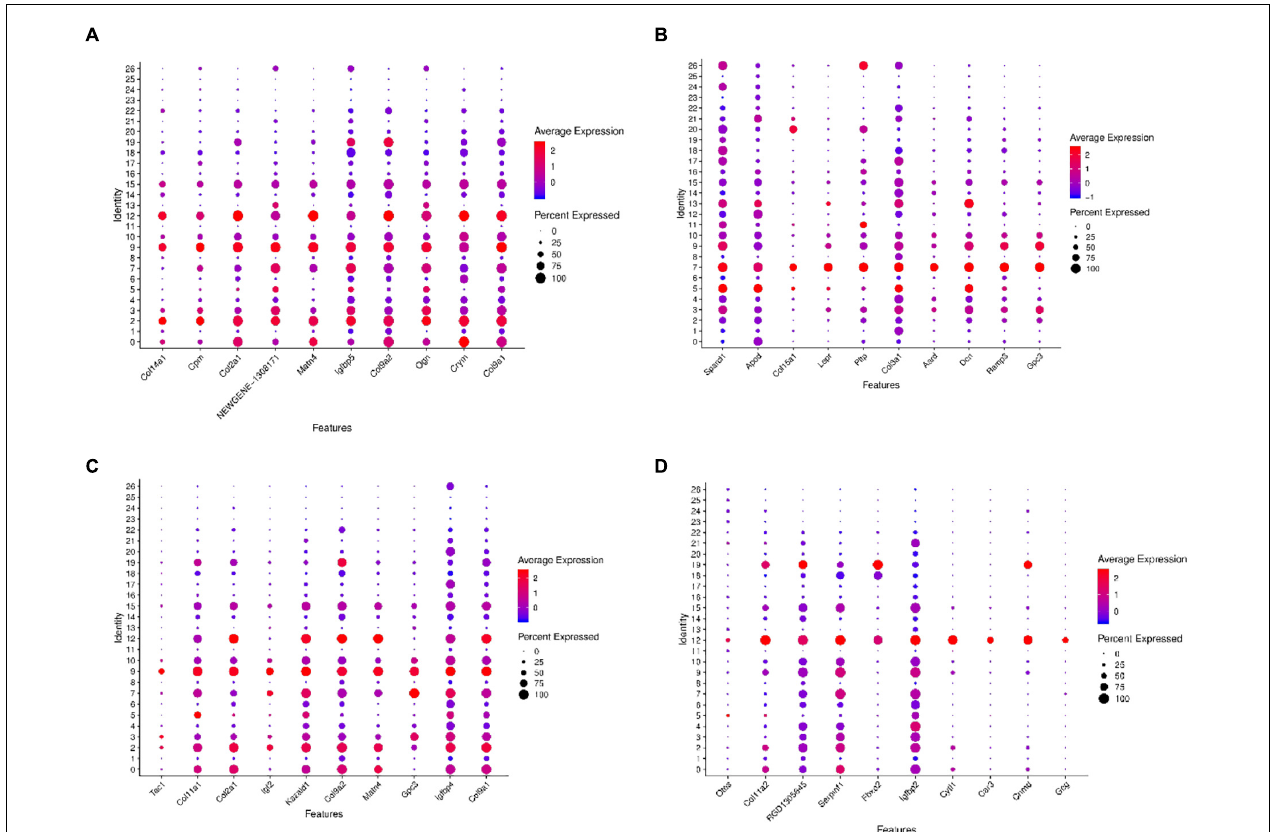
FIGURE 9 | Dot plots representing expression levels of the KO2, KO7, KO9, and KO12 clusters. All samples were analyzed using dot plot analysis with the Seurat R package. Expression levels of the top ten genes on cluster 2 (A) , cluster 7 (B) , cluster 9 (C) , cluster 12 (D) are shown. Each dot was sized to represent the proportion of cells of each type expressing the marker gene and colored to represent the mean expression of each marker gene across all